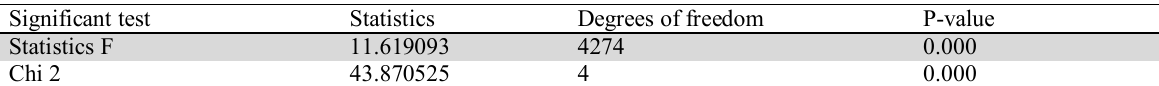
Results of chow test Significant test